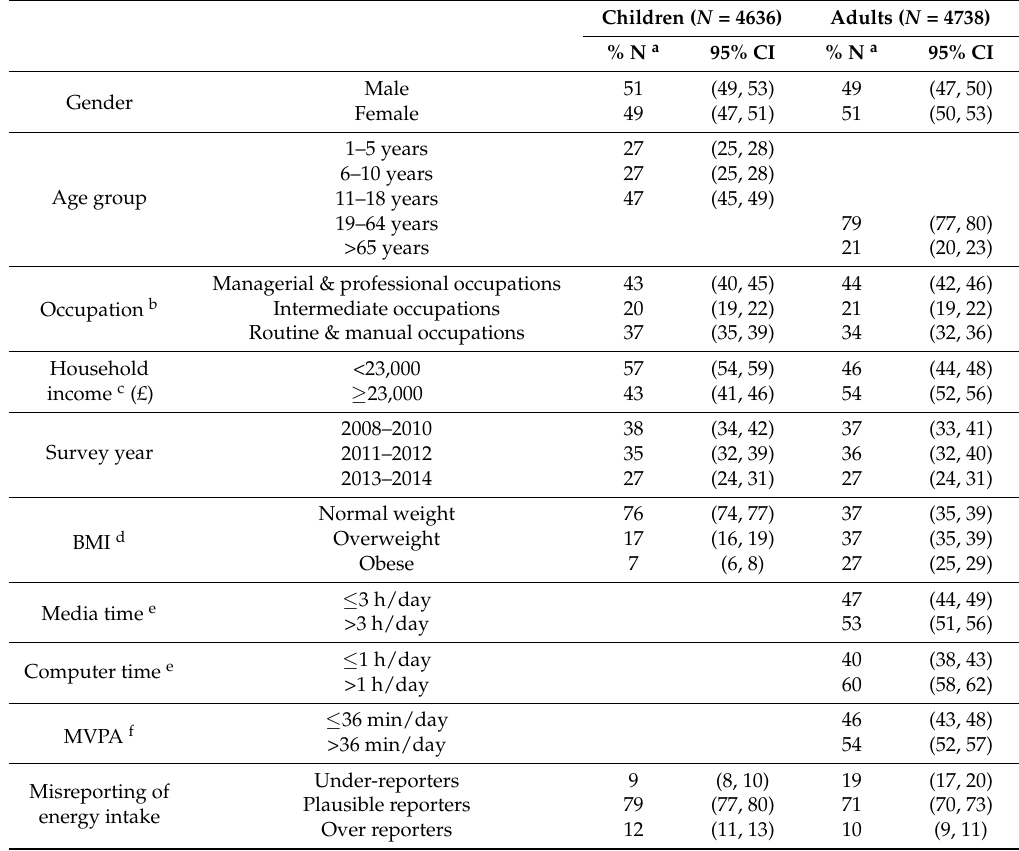
Table 1. Description of the National Diet and Nutrition Survey children and adult sample in